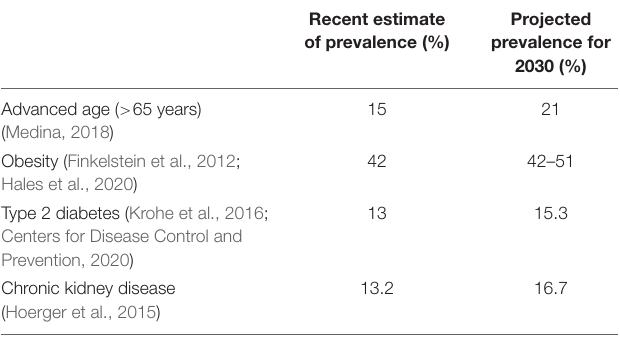
TABLE 1 | The prevalence of conditions known to impact muscle regeneration is going to increase.